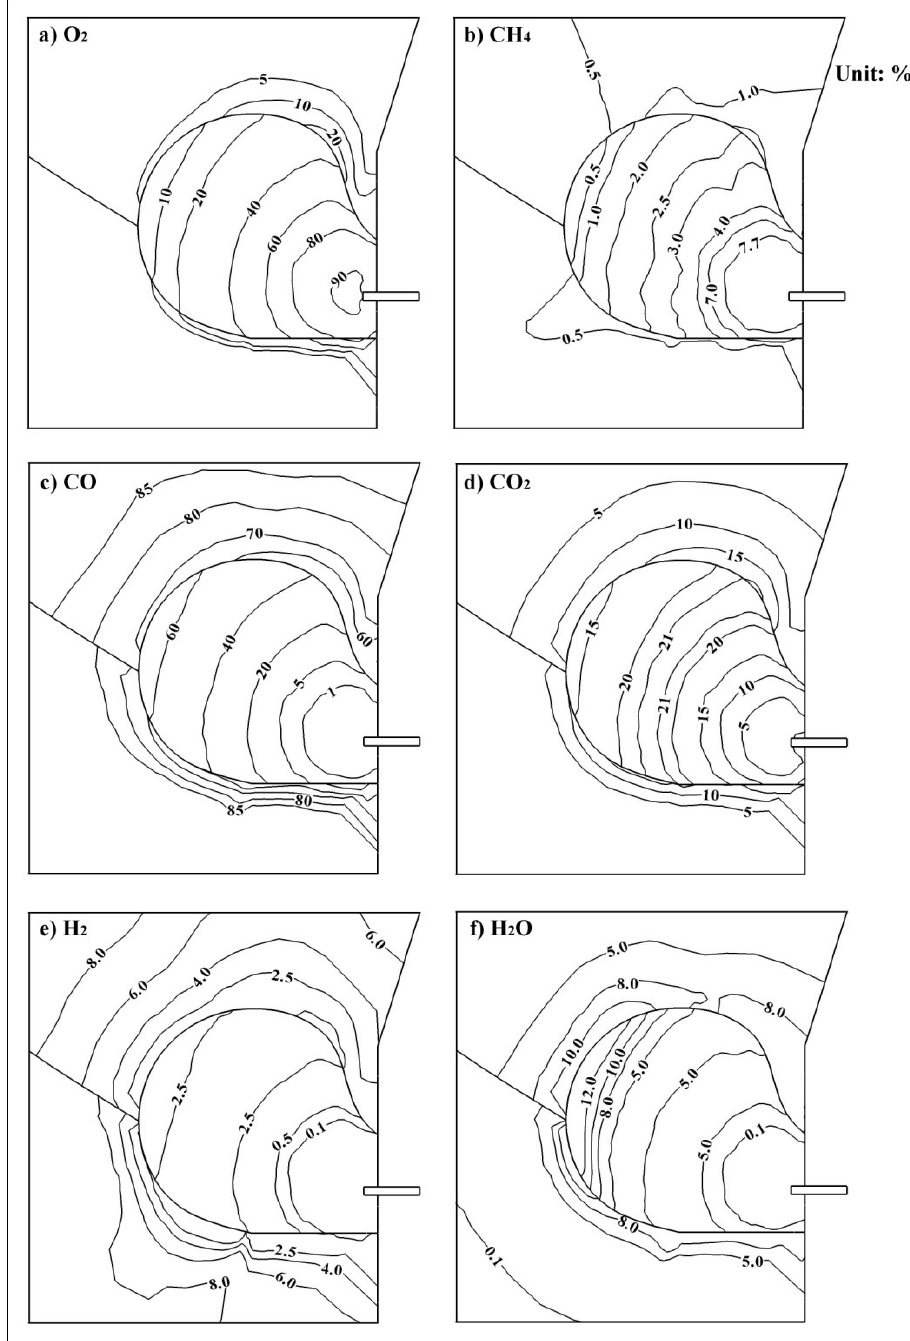
Figure 8: Volume fraction distributions of gas species around raceway for additional NG injection with a concentration of